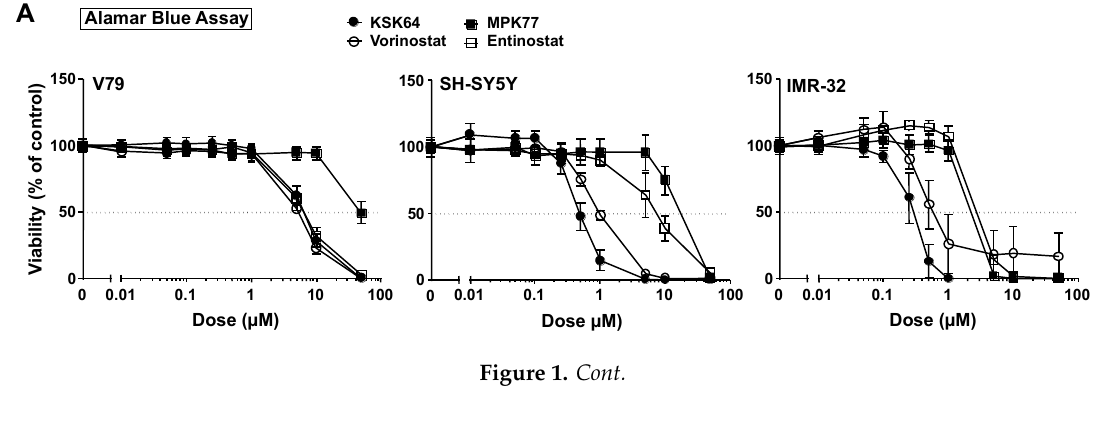
Figure 1. Comparative analysis of the cytotoxicity of novel hydroxamic acid- and benzamide-type histone deacetylase inhibitors (HDACi). Cell viability was analyzed 72 h after administration of representative HDACi candidate compounds (i.e. hydroxamic acid-type HDACi: KSK64, vorinostat; benzamide-type HDACi: MPK77, entinostat) using the Alamar blue and the Neutral red assay. The neuroblastoma cell lines IMR-32 and SY-SY5Y were used as a tumor cell model, whereas V79 lung hamster cells were employed as non-malignant counterpart according to the international OECD (Organisation for Economic Co-operation and Development) guidelines for toxicity testings. (A) Cell